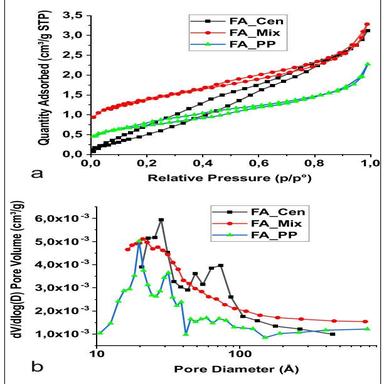
a) Nitrogen adsorption/desorption isotherms and b) the corresponding pore size distributions determined for FA_Cen, FA_Mix and FA_PP ash samples.